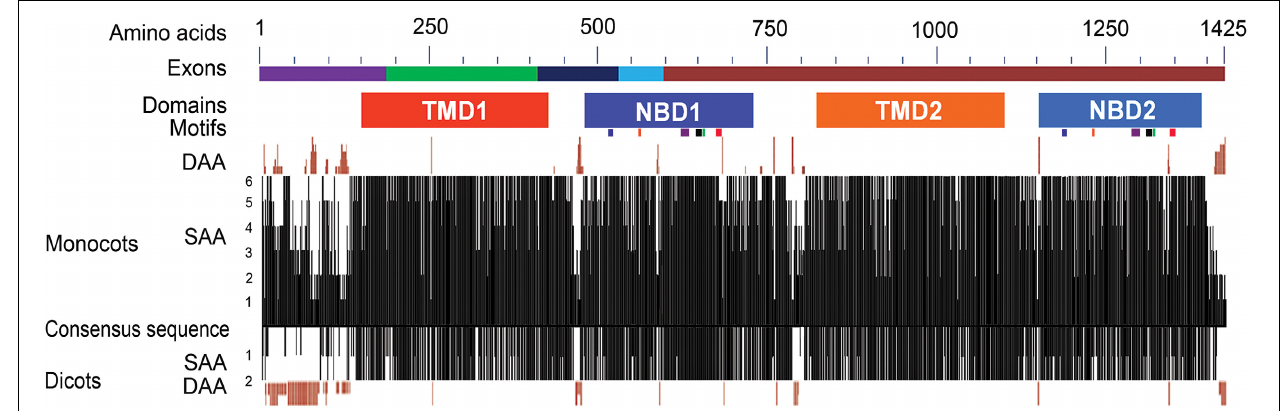
FIGURE 2 | Structural features and sequence similarity of the predicted ABCB1 proteins. The sequence differences in NBDs and TMDs between two halves of ABCB1 proteins are depicted with shades of different colors. The exons marked with different colors above the consensus sequence are drawn according to that of maize. The six known motifs (from left to right in each NBD—Walker A, Q-loop, ABC transport signature, Walker B, D-loop, and